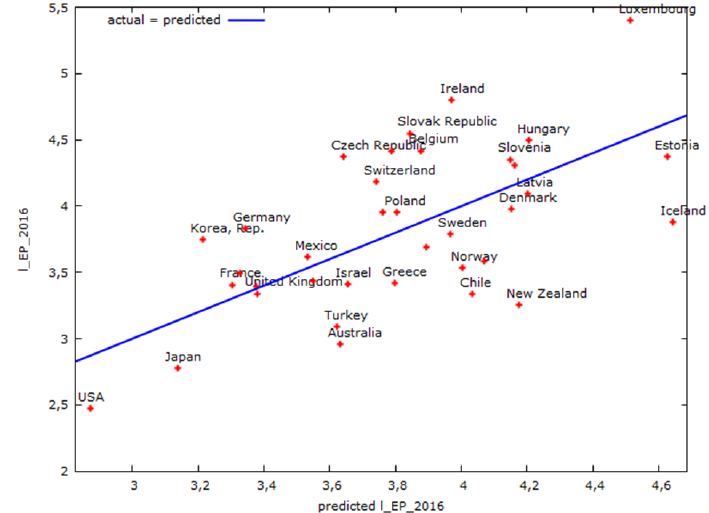
Fig. 1 – Figure of actual and predicted values of a dependent variable (EP_2016). Source: own processing